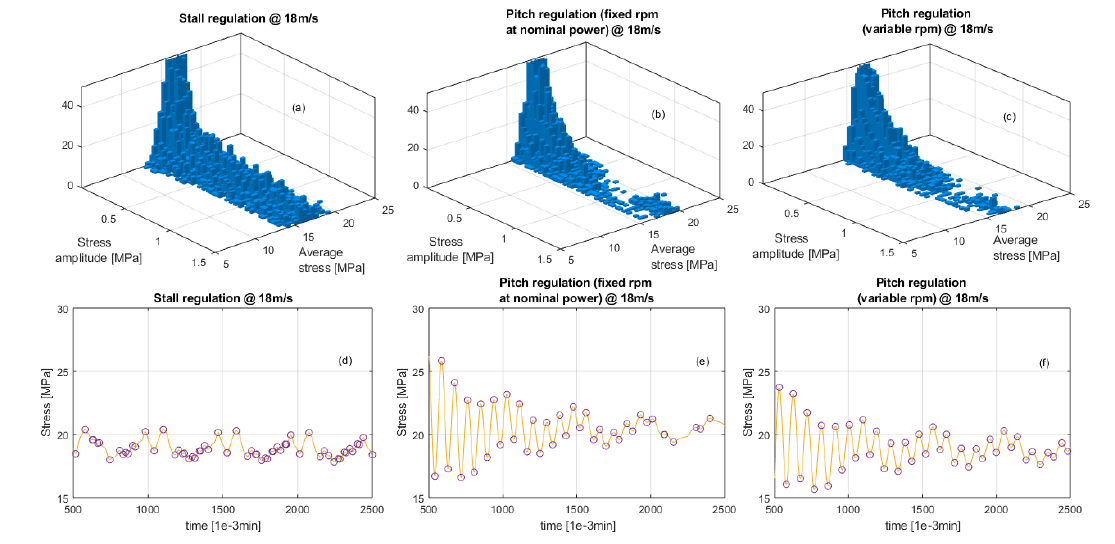
Figure 10. Results of the rainflow analysis for 18 m/s. Upper row ( a – c ): results of the rainflow analysis for the three regulation schemes. Lower row ( d – f ): corresponding time series with inflection points